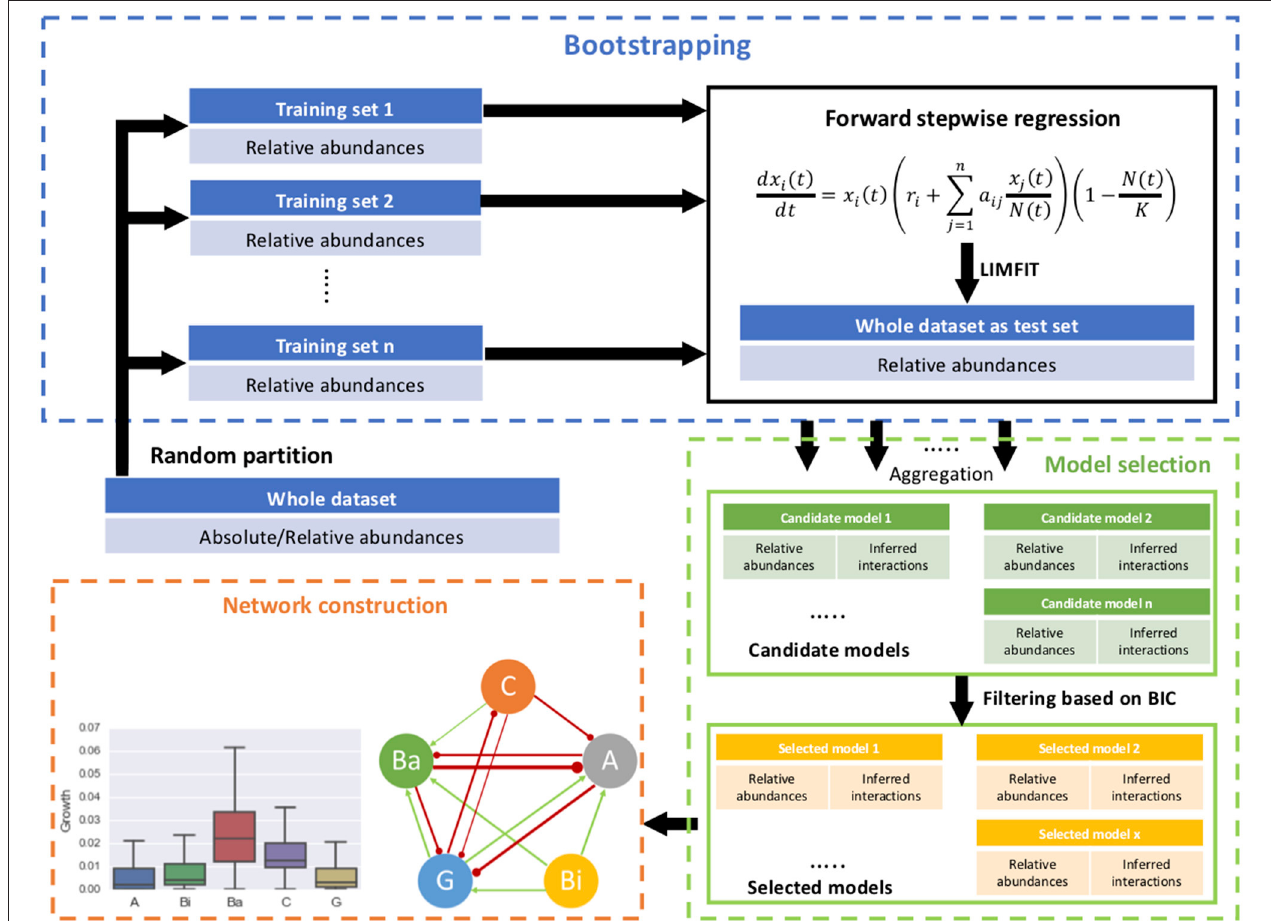
FIGURE 1 | Schematic diagram of the proposed procedure, consisting of forward stepwise regression, bootstrap aggregating, model selection, and network